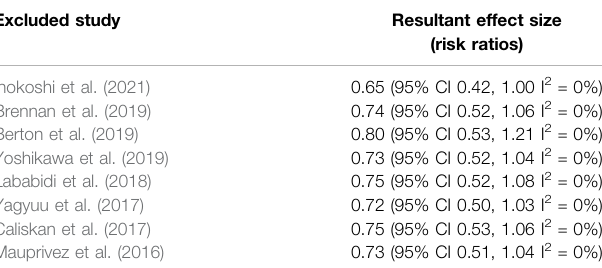
TABLE 3 | Results of sensitivity